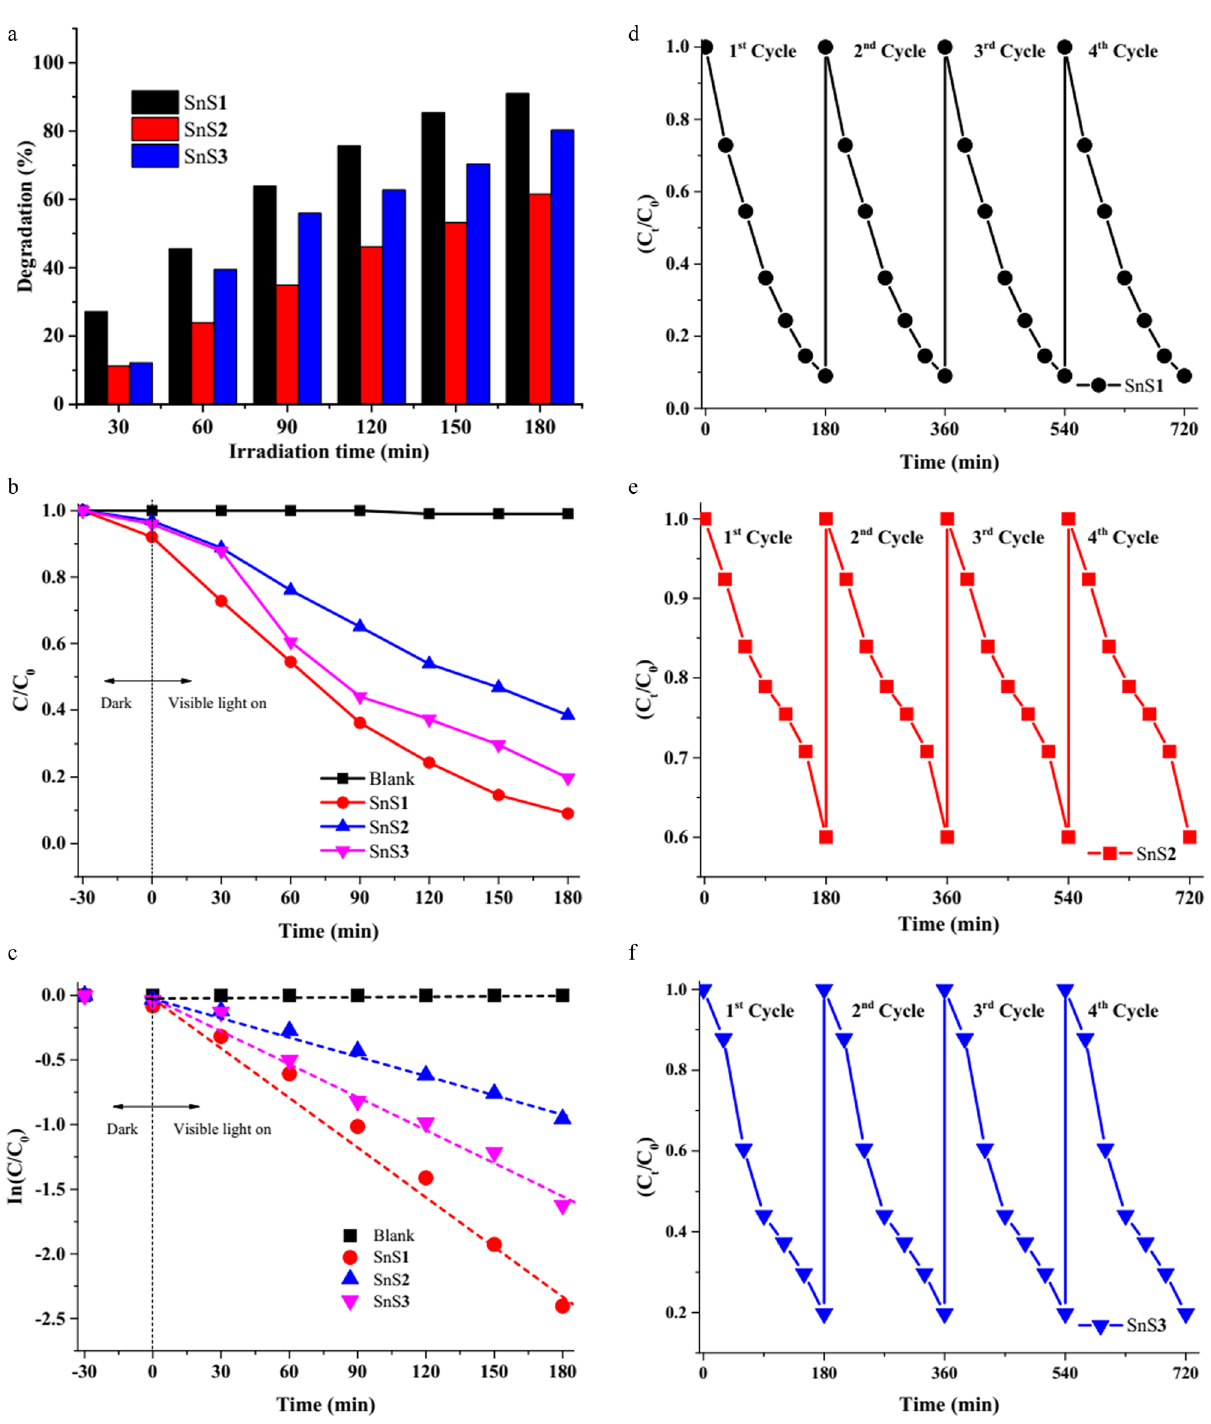
Figure 4: ( a ) Degradation bar chart; ( b ) plot of C t / C 0 versus time; ( c ) kinetic studies; ( d – f ) recycling runs using SnS as photocatalyst for rhodamine B